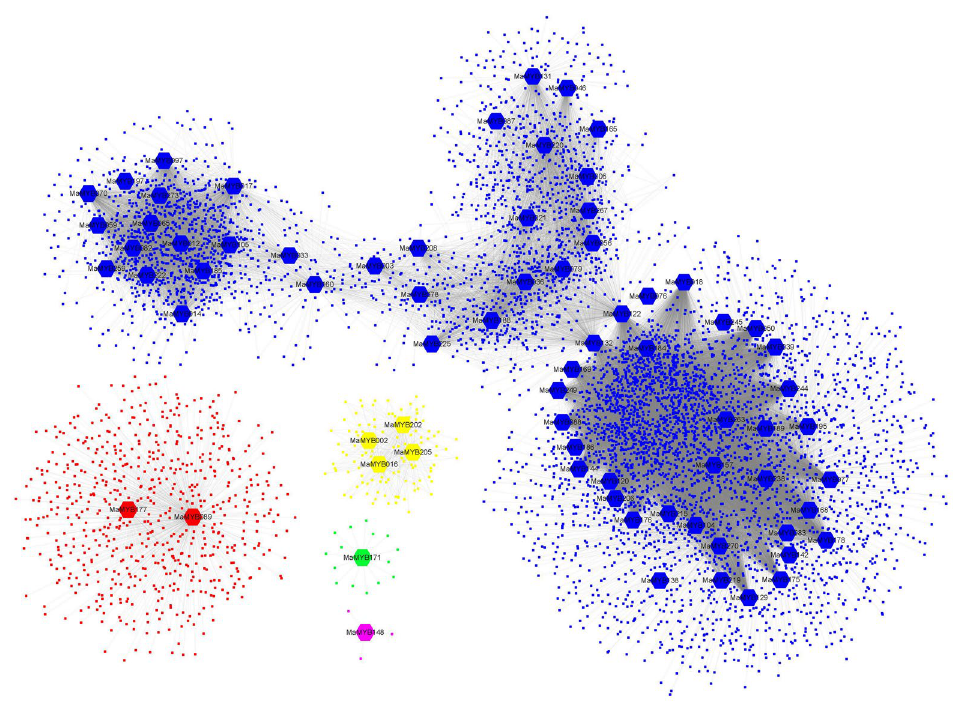
Figure 6. Co-expression network of banana generated using the MaMYBs as guides. The network comprises 6118 genes (nodes); the hexagon represents MaMYB s ; blue represents module I, red represents module II, yellow represents module III, green represents module VI, and purple represents module V.